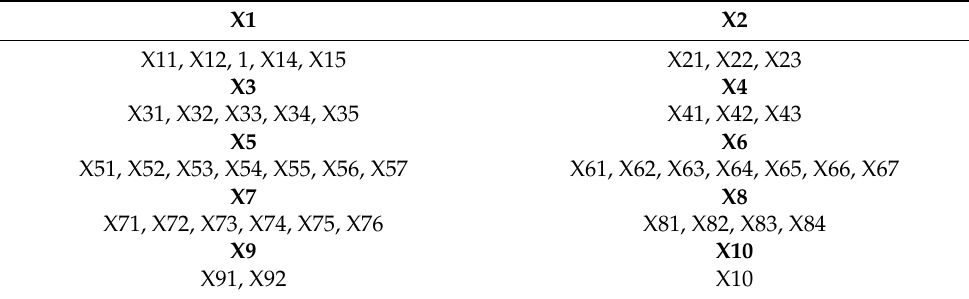
Table 6. Multiple inputs and